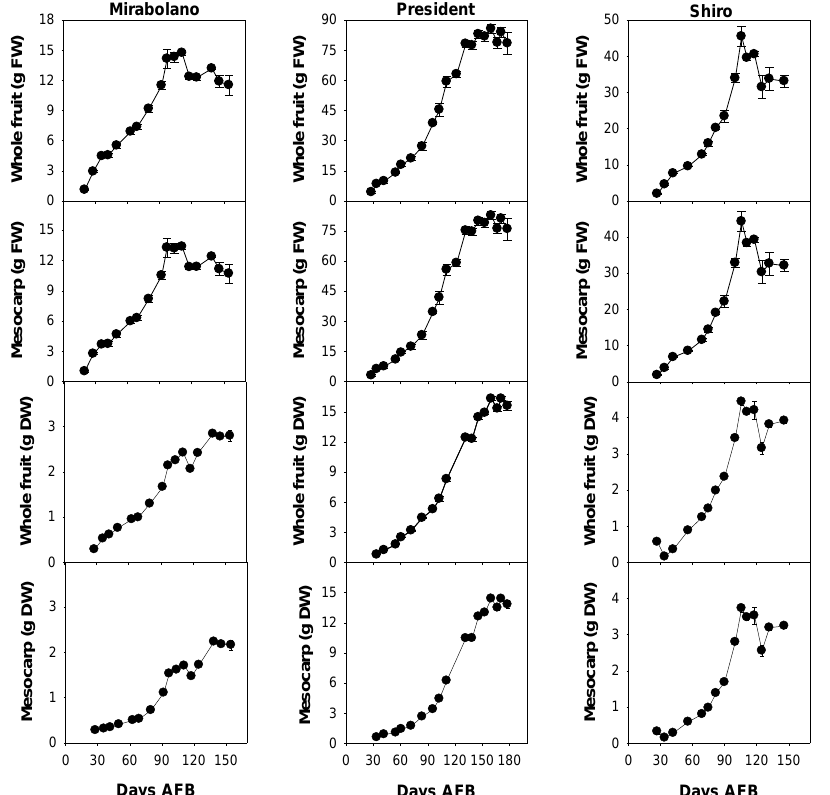
Figure 1. Fresh and dry weights of both the whole fruit and its flesh (mesocarp + epicarp) of Prunus cerasifera —Mirabolano, Prunus domestica —cultivar President, and Prunus salicina —cultivar Shiro at different stages of development. Each point on the graph shows the mean and standard error, n =15. AFB = after full bloom.